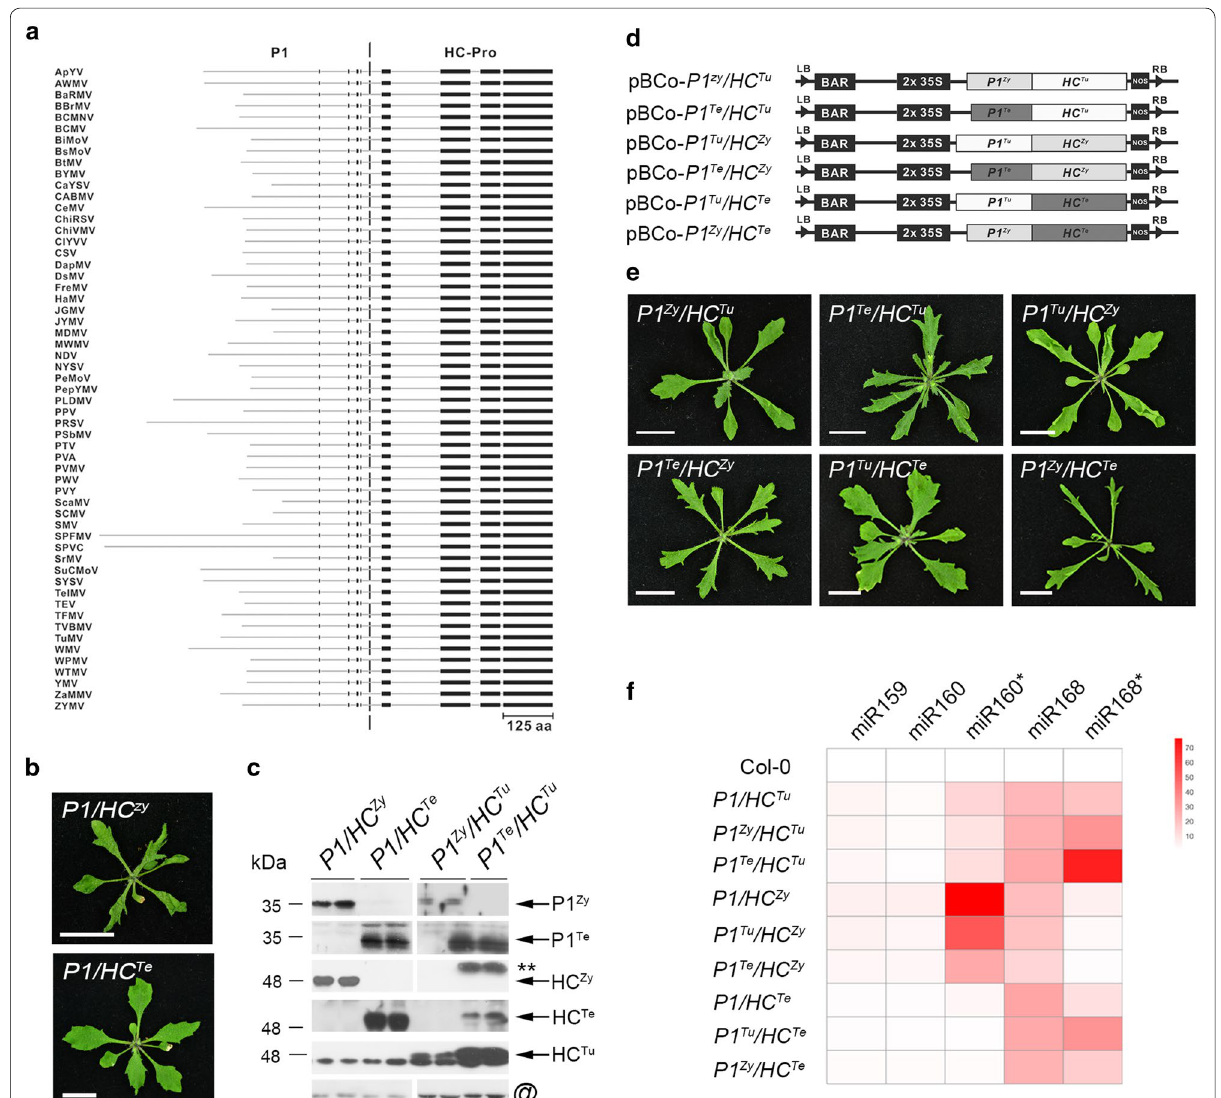
Fig. 2 Variation in potyvirus P1/HC‑Pro and recombined P1/HC ‑ Pro plants. a Schematic diagram of P1 and HC‑Pro amino acid sequence similarity among fifty‑seven Potyviruses . The black boxes indicate conserved sequence regions. b The morphologic phenotype of P1/HC Zy and P1/HC Te plants. Bar, 1 cm. c . Detection of P1 and HC‑Pro in P1/HC Zy , P1/HC Te , P1 Zy /HC Tu , and P1 Te /HC Tu plants. The @ symbol indicates CDC2 as an internal control. Two‑asterisk (**) indicate cross‑reaction of the α‑HC Zy antibodies. d Schematic of the binary plasmids containing the various recombined P1/ HC ‑ Pro constructs used in this study. e Phenotypes of various recombinant P1/HC ‑ Pro transgenic plants. The photographs were taken of 3‑week‑old seedlings. Bar, 1 cm. f Heatmap of abnormal miRNA and miRNA* accumulation in various recombinant P1/HC ‑ Pro plants. The values of heatmap were convert from miRNA northern blot. Significant upregulation (Student’s t test; P value < 0.05) is labeled in red. Gray indicates differential expression that is not significant. The values on the right indicate the results of the log 2 (each sample/Col‑0)